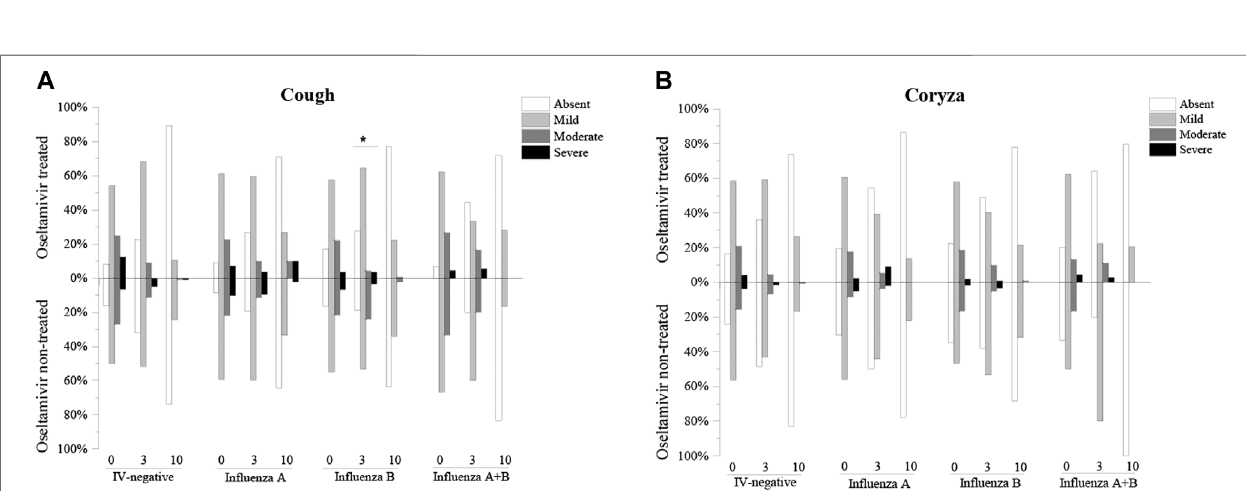
Frontiers in Pharmacology |